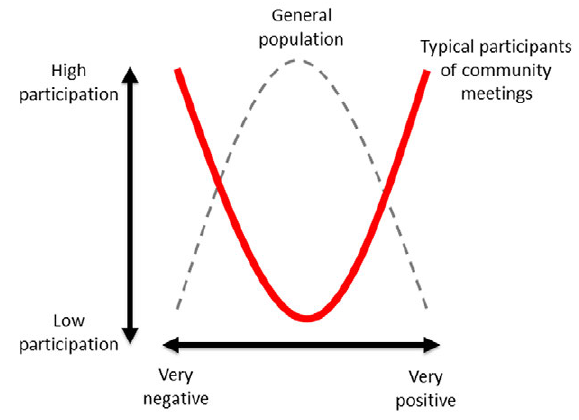
Fig. 2. An author´s visualisation of the non-response bias in community affairs surveys.